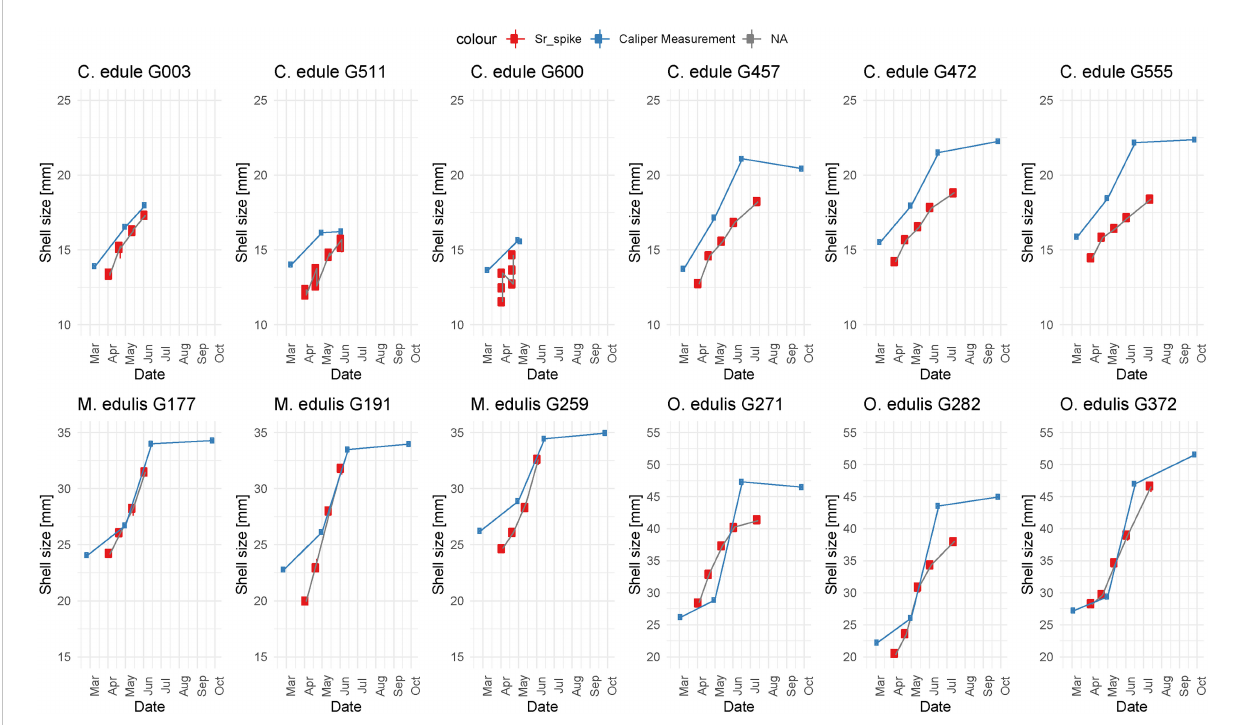
FIGURE 7 Plot showing measured shell size over time (in blue) and shell size over time inferred from the location of Sr spikes (in red) for all specimens. Vertical scales are constant between specimens of the same species, but different between species. Note that three parallel LAICPMS line scans were measured on cockle specimens G003, G511 and G600, resulting in multiple Sr spiking shell growth estimates at the same time of